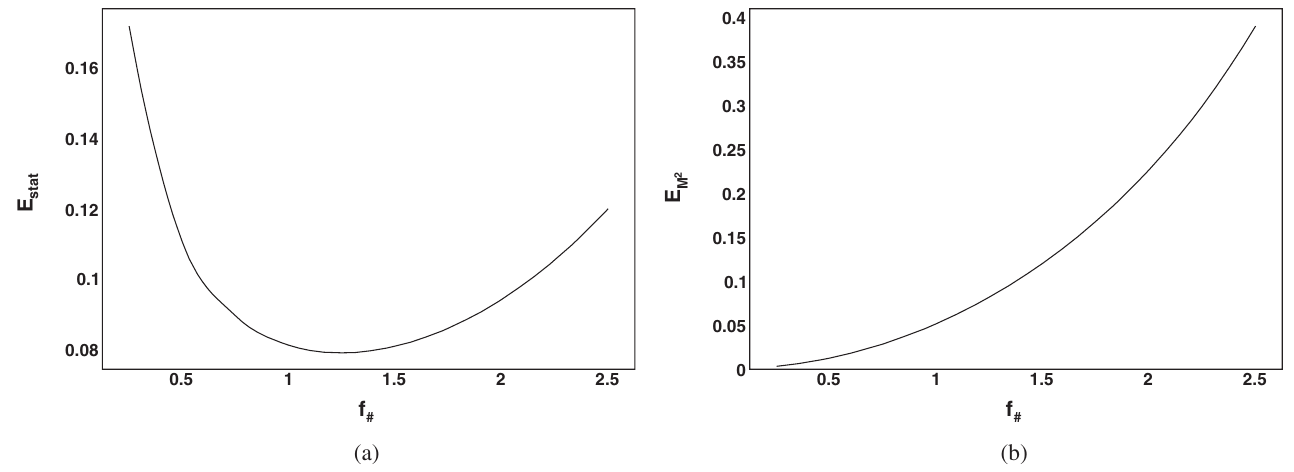
(cid:1) 19 scan points versus the f -number of the , (b) laser error E for (cid:14) (cid:1) 1 [Eq. (20)] using N stat scan M 2 mode with (cid:13) (cid:1) 532 nm . The electron bunch is assumed to 00 (cid:1) 1 (cid:3) m and (cid:2) (cid:1) 25 (cid:3) m ey ex